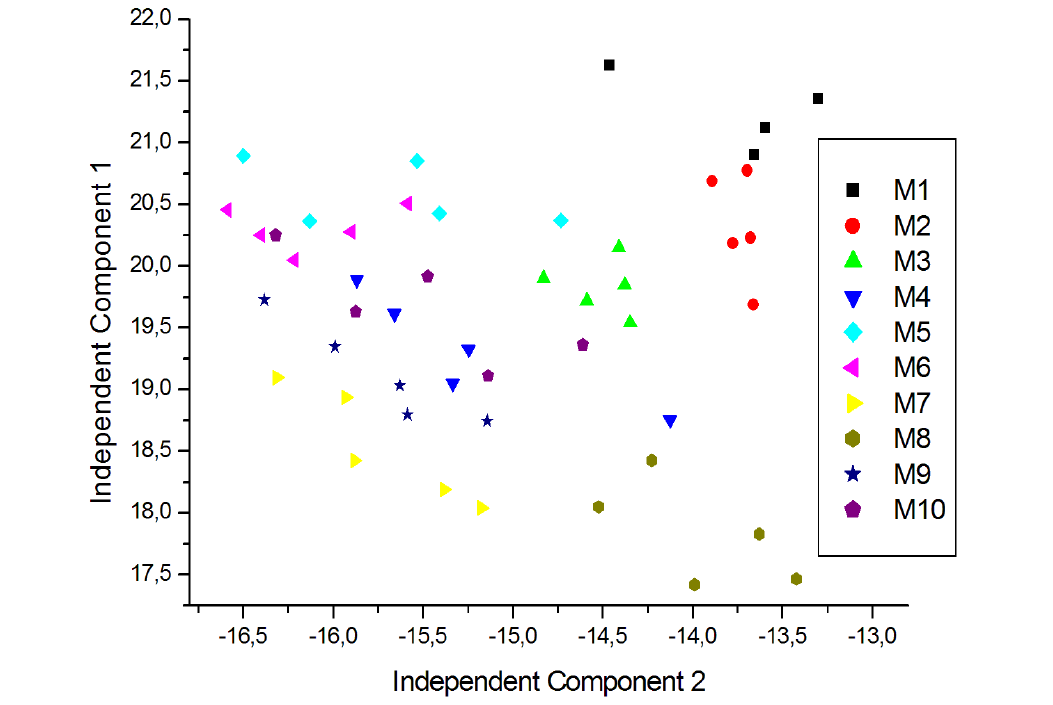
Figure 9. ICA plot of the aged red wine